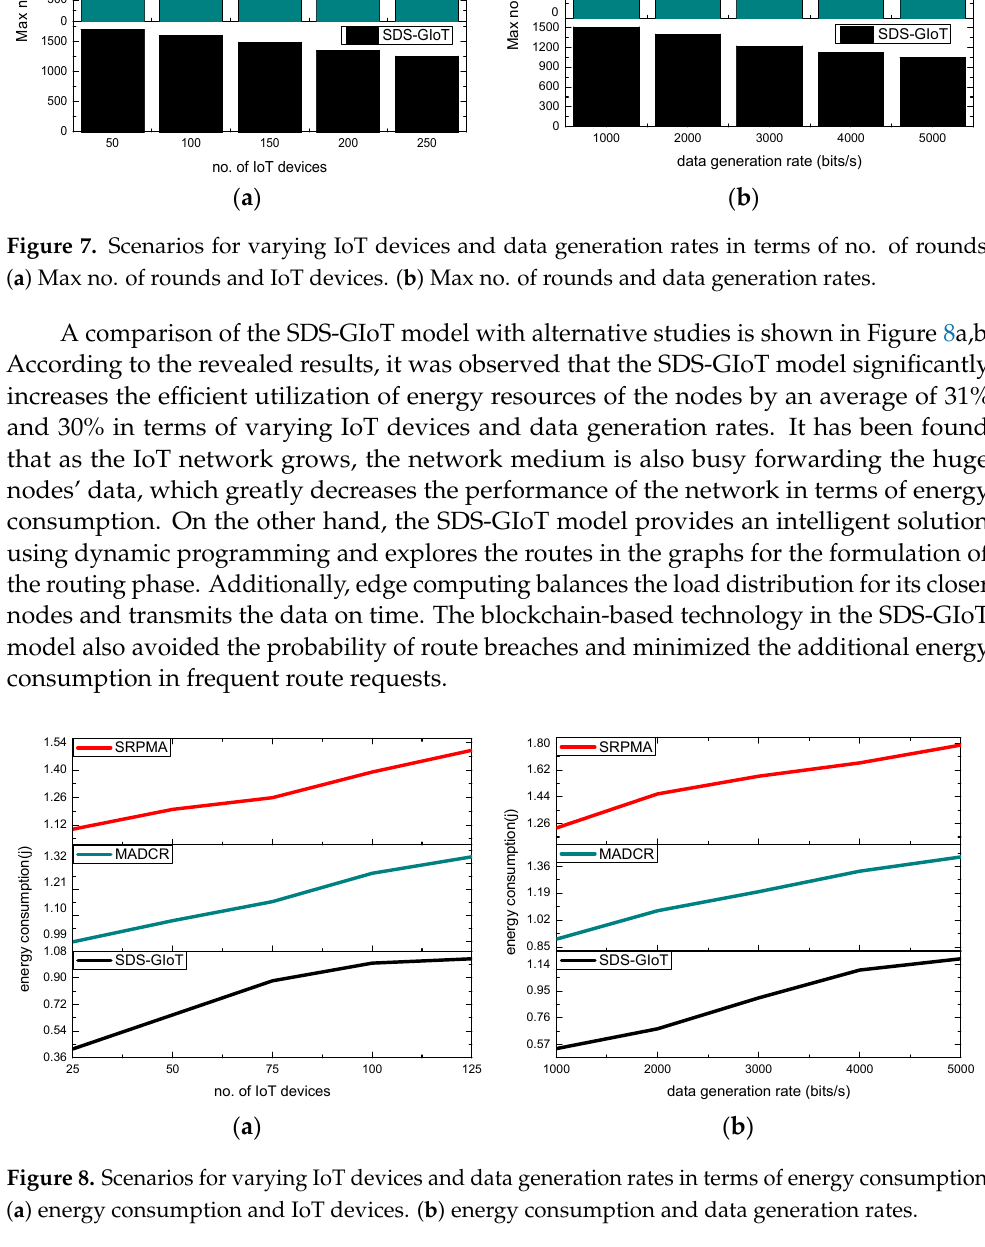
( b ) Figure 6. Scenarios for varying IoT devices and data generation rates in terms of communication complexity. ( a ) communication complexity and IoT devices. ( b ) communication complexity and data generation rates.